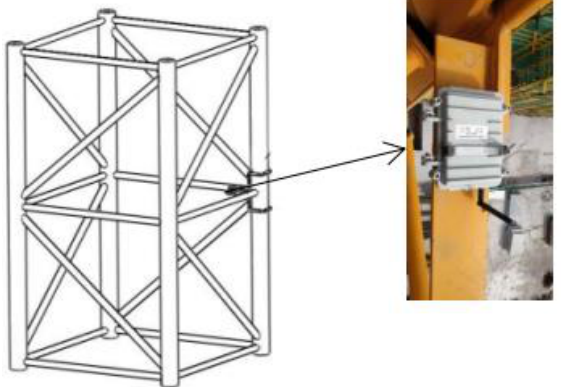
Figure 5. Detailed view of sensor arrangement.